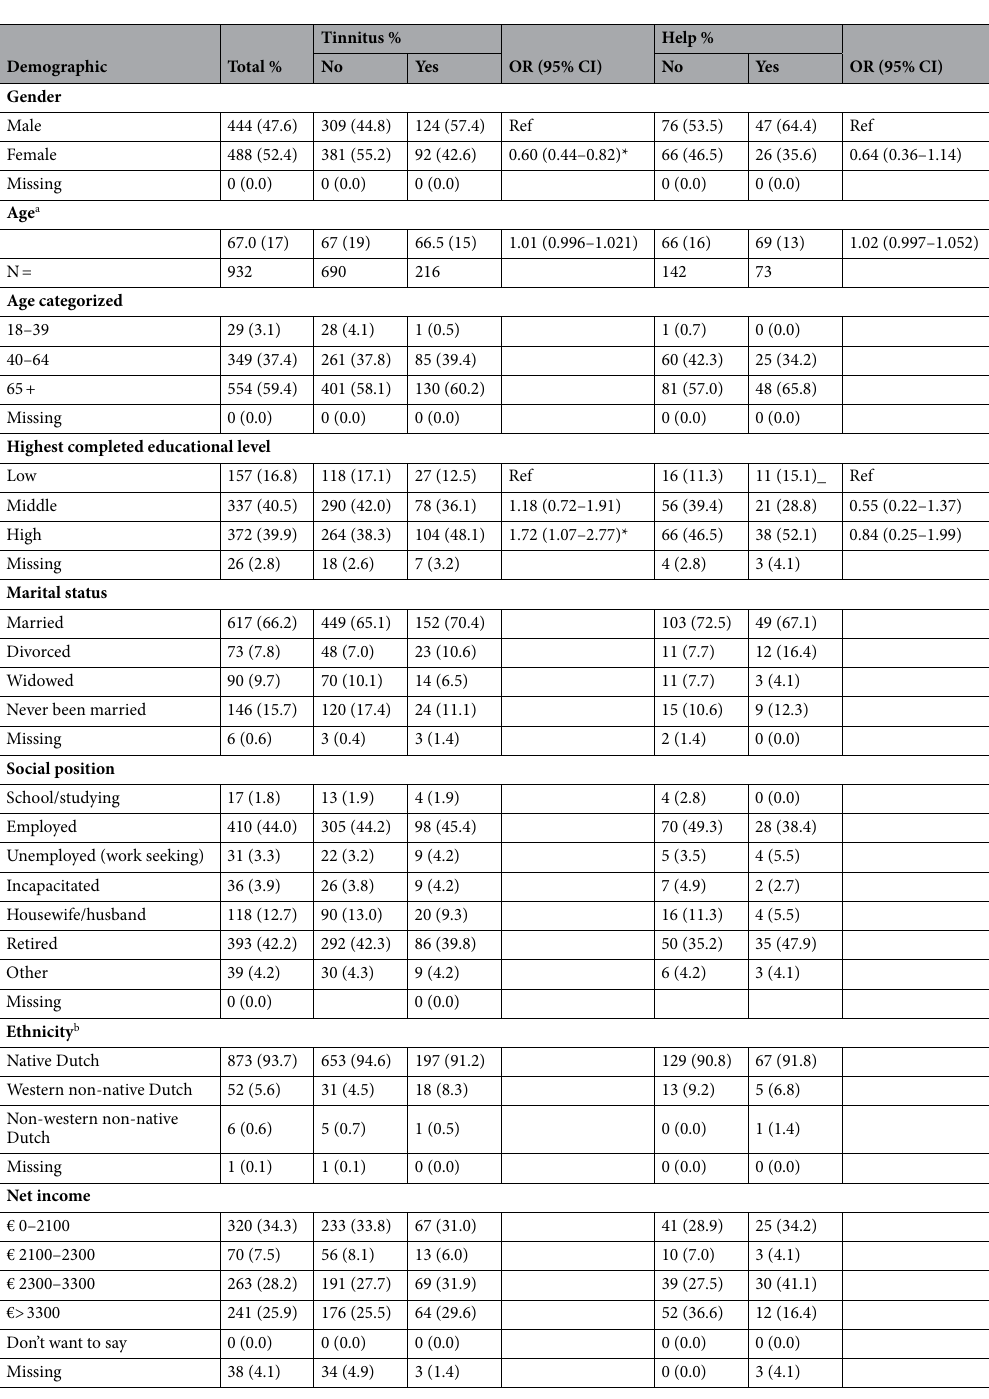
Table 1. Demographic characteristics. Please see Supplementary Table S2 for answer to social position, other. a Median (IQR) * p < 0.05. b Based on country of birth of the